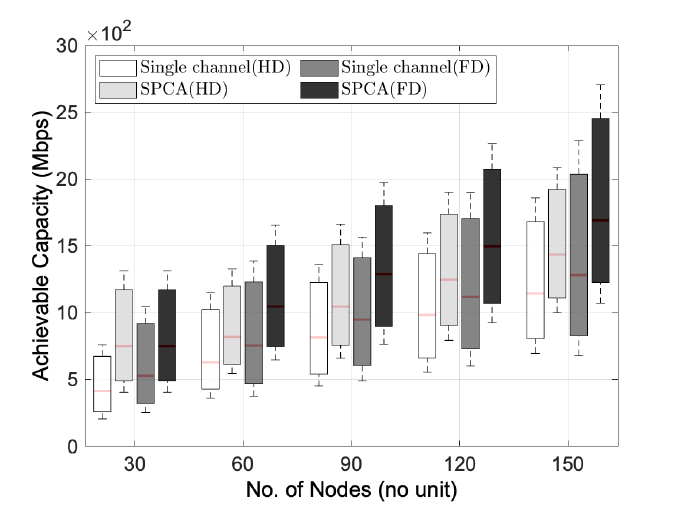
Figure 4. Performance comparison between HD and FD transmission modes for the distribution of achievable capacity versus the number of